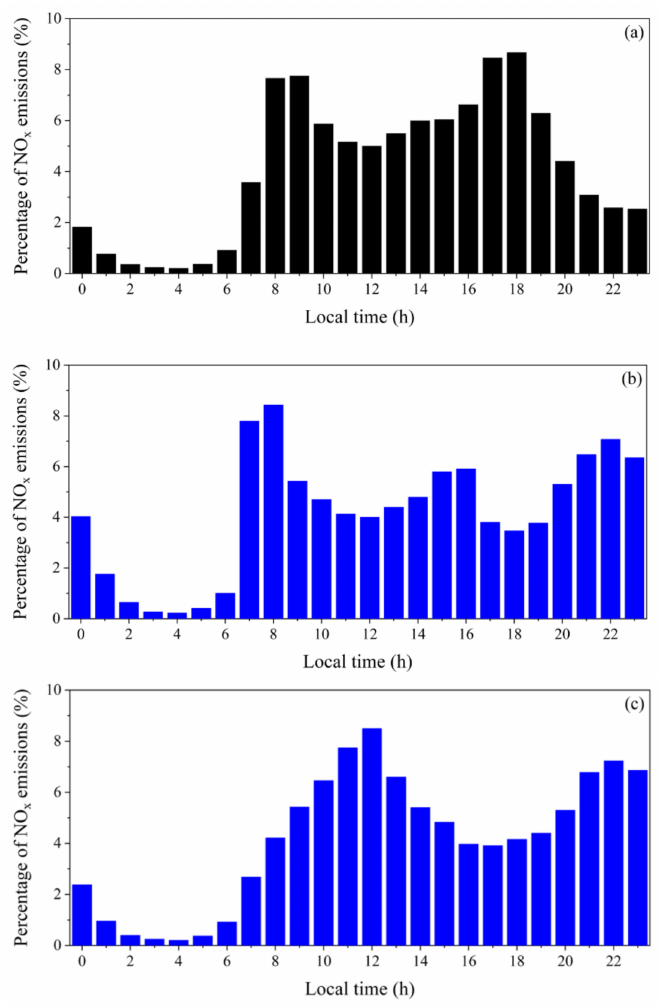
Figure 4. Temporal distribution of transport emissions from: ( a ) the original emission inventory, ( b ) the urban inventory for weekdays and ( c ) the urban inventory for weekends. Shipping emissions (SNAP 99) are equally distributed to the grid cells with shipping lanes (Figure